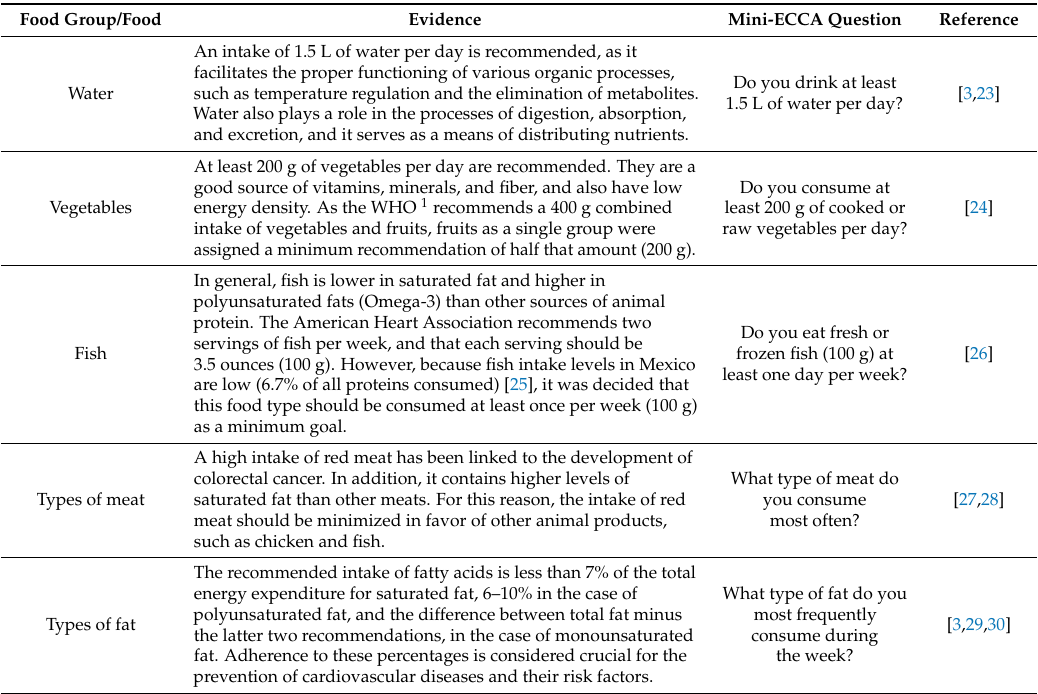
Table 1. Recommendations used to prepare the Mini-ECCA and questions, which were developed based recommendations (images and options are shown simultaneously in a picture when asking the Mini-ECCA